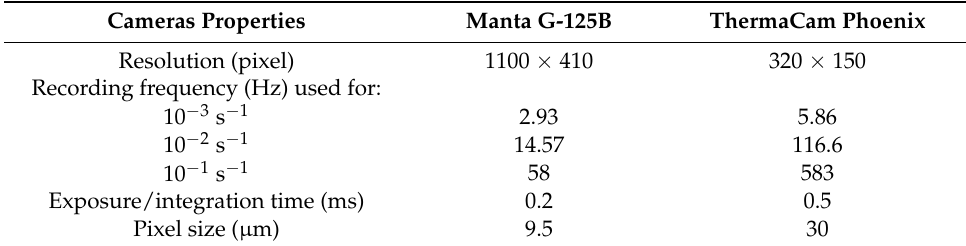
Table 1. Settings of visible and infrared cameras used in the